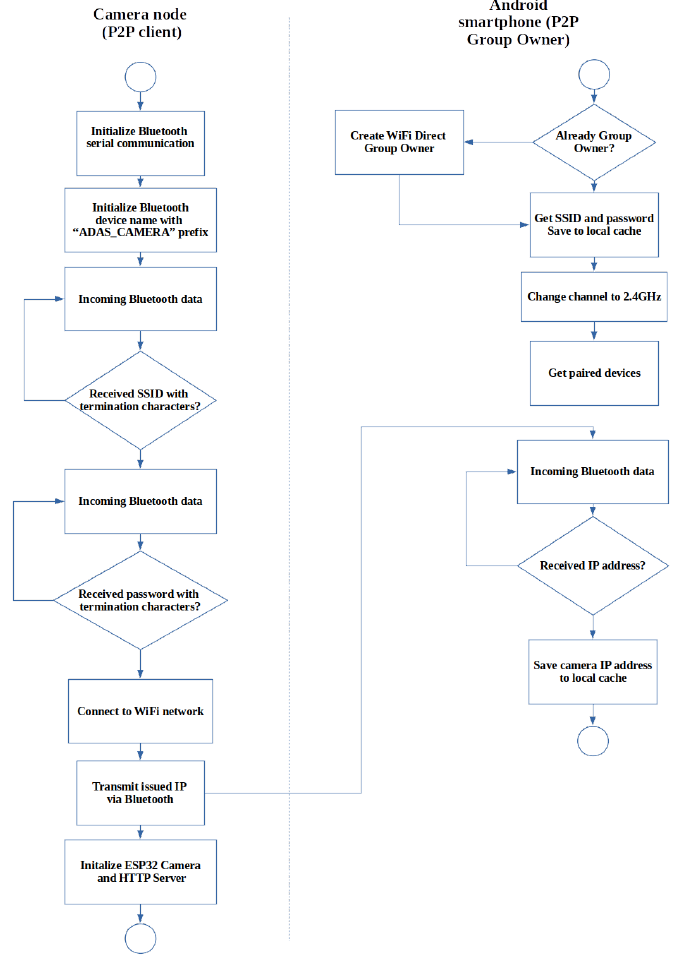
Figure 5. Network communication